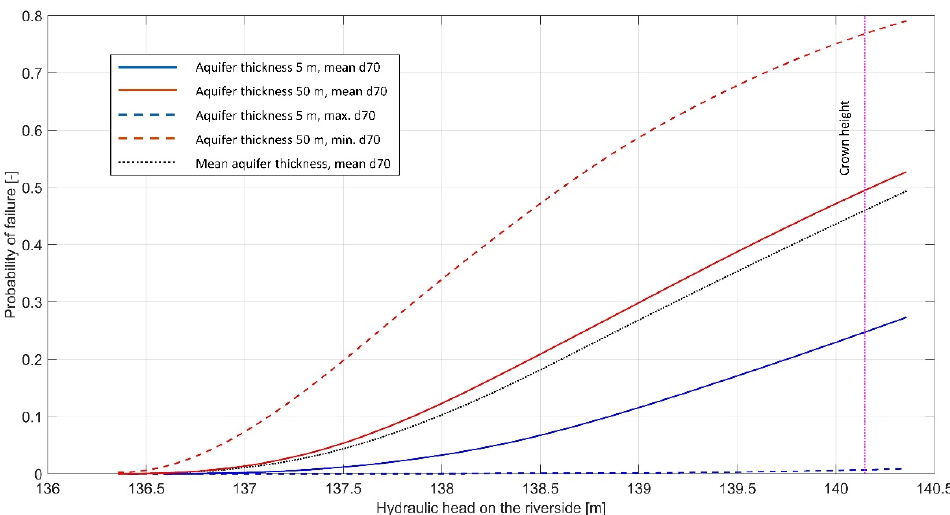
Figure 12. Probability of piping failure for PDC2.